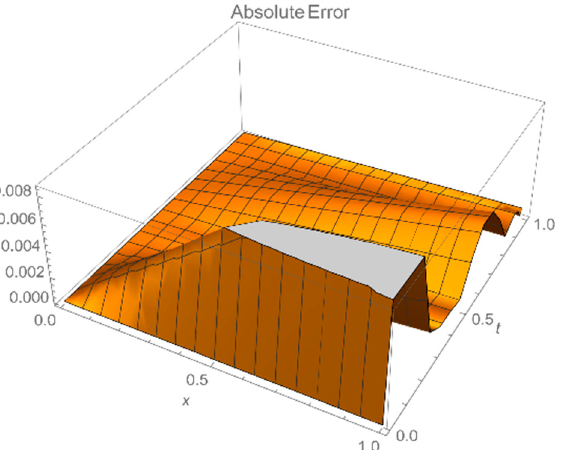
Figure 5. A 3D plot of the absolute error between approximate and exact solutions of Example 4 with n = 4-degree of B-polys is shown in two variables ( x , t ). The approximate solution has not converged yet.